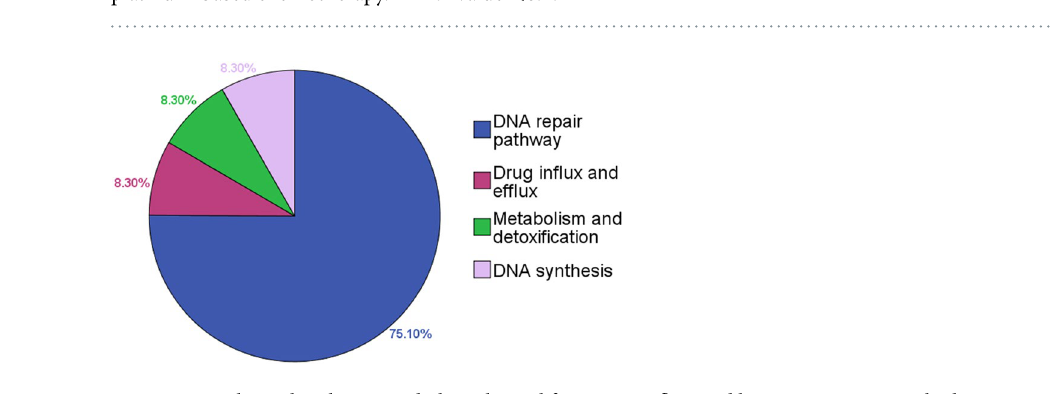
Figure 2. Biological pathways and physiological functions influenced by genetic variants which were statistically significantly associated with clinical outcomes of platinum-based chemotherapy in NSCLC